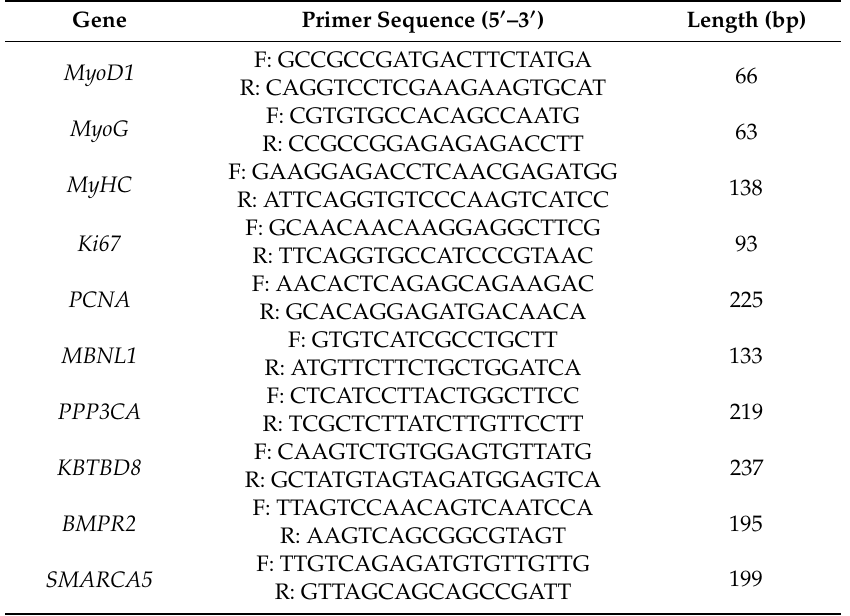
Table 2. Primers for